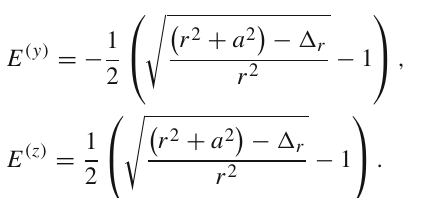
Substituting the values of a ( x ) , a ( y ) and a ( z ) from Eqs. (36)– (38), we